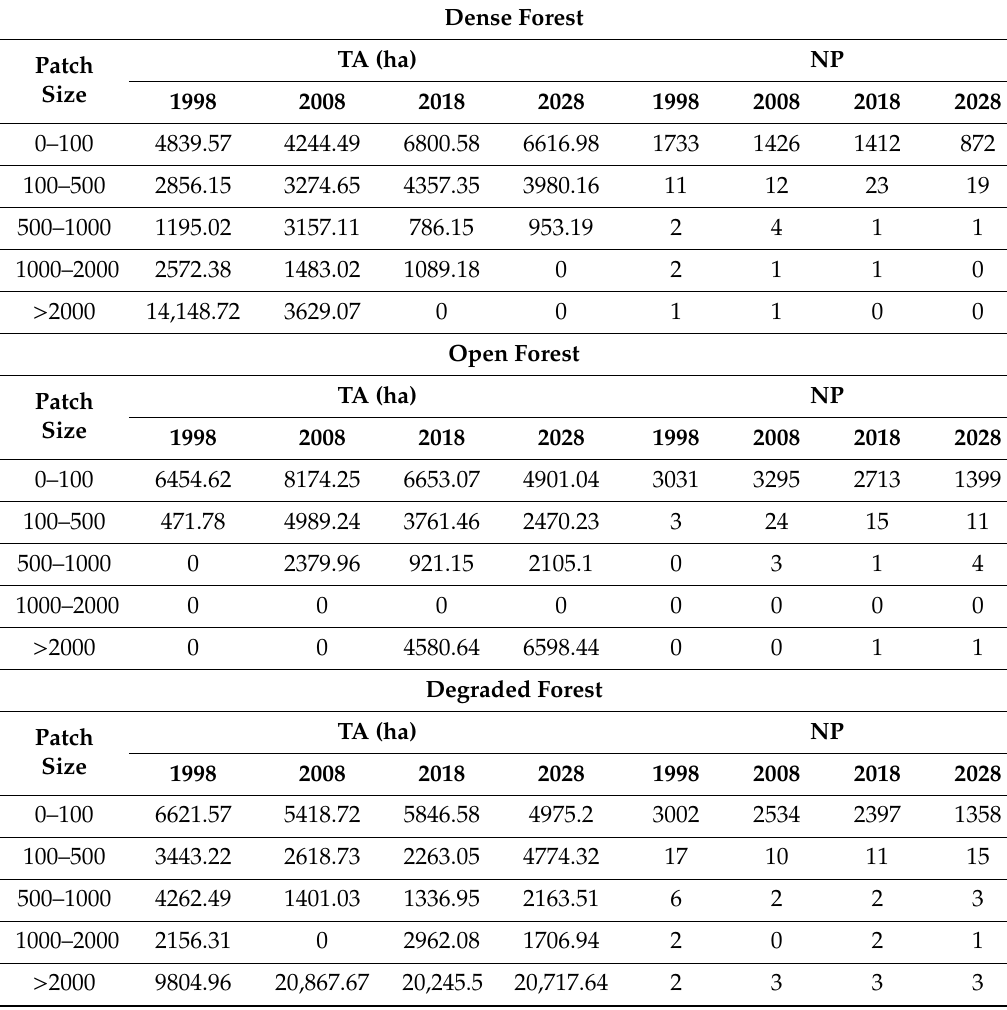
Table 2. Patch level analysis of Total Area (TA) and No of Pataches (NP) for di ff erent forest covers classes.